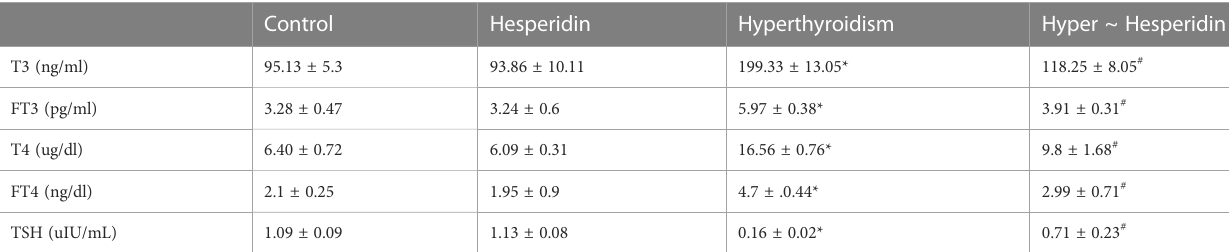
TABLE 2 Serum T3, FT3, T4, FT4 and TSH levels of healthy and hyperthyroidism -treated animals ’ groups as compared to control